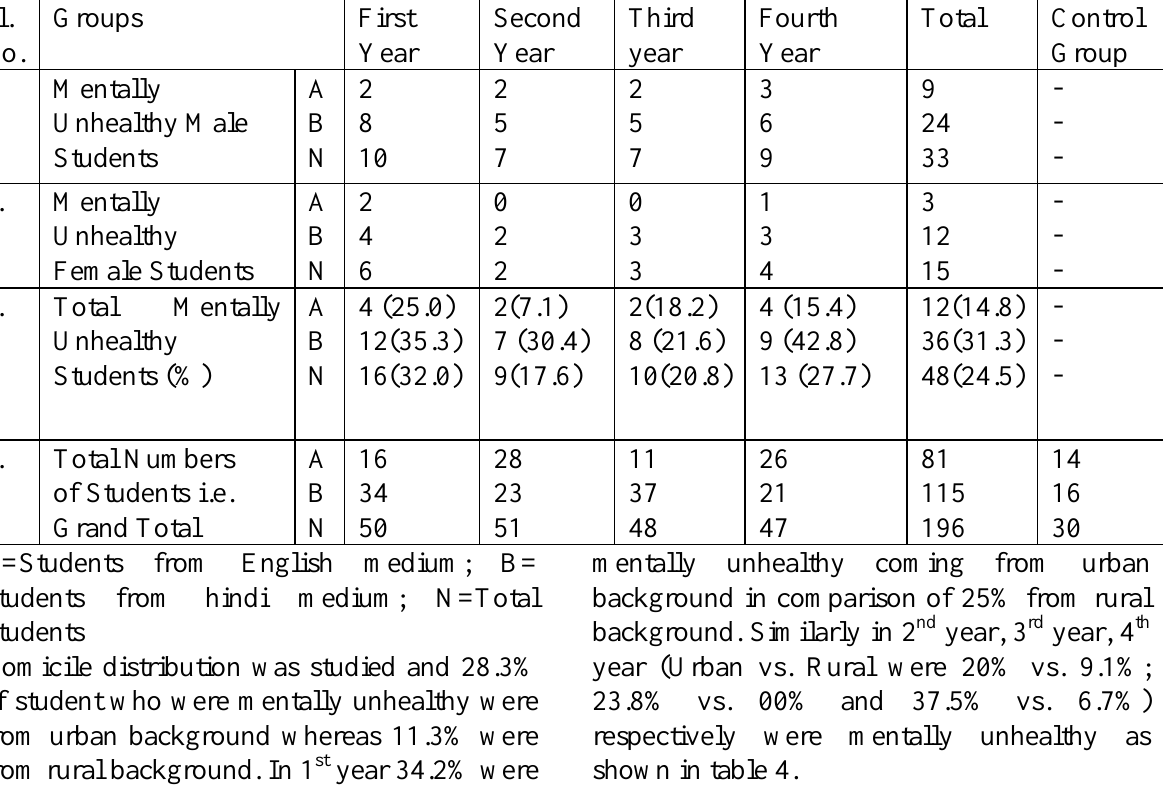
Table3. Language distribution of Mentally healthy and unhealthy Engineering students Sl.